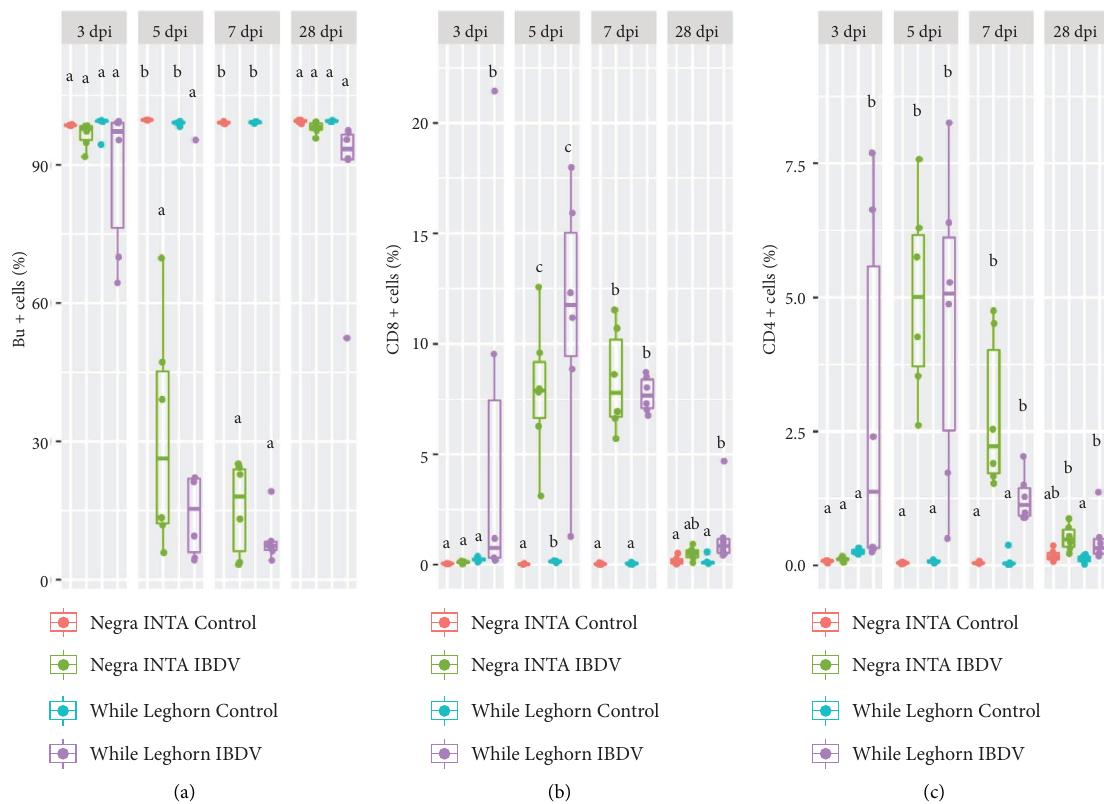
Figure 6: Analysis of lymphocyte populations by fow cytometry. Mononuclear cells were isolated from bursae, stained with diferent combinations of antibodies and analyzed by fow cytometry. Te lymphocyte population was gated according to their size and complexity. Te results show the percentage of cells in each of the groups analyzed. (a) Percentage of Bu+, (b) CD8+, and (c) CD4+ cells in the bursa. Percentages values (dots) as well as box plots representing data distribution are shown for each group. Diferent letters indicate signifcant diferences among groups (one-way ANOVA test and Tukey post-hoc test, p < 0 .